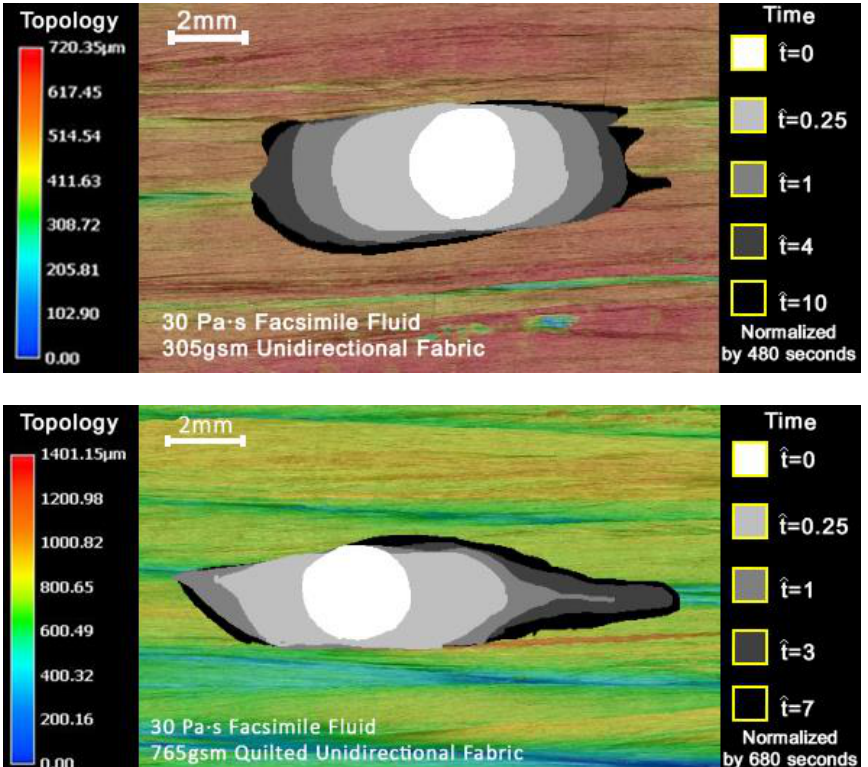
Figure 10. Images showing the contours of the area infiltrated by fluid over time, overlaid onto a topographical representation of the fiber bed for the 30 Pa·s viscosity fluid tests on fabric C ( above ) and fabric D ( below ).